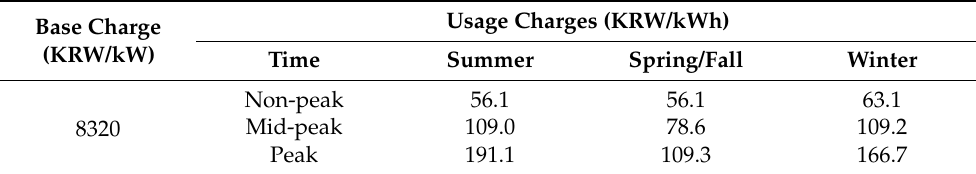
Table 2. Electricity rate in Korea.